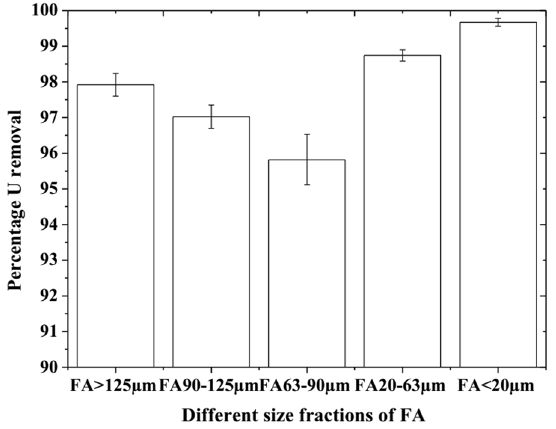
Fig. 16 a Photodegradation of MO dye by FA/CuO and b Plot of A/Ao versus time (Mazumder et al. 2018) Table 6 Permissible limits of heavy metals in water (Ahmed and